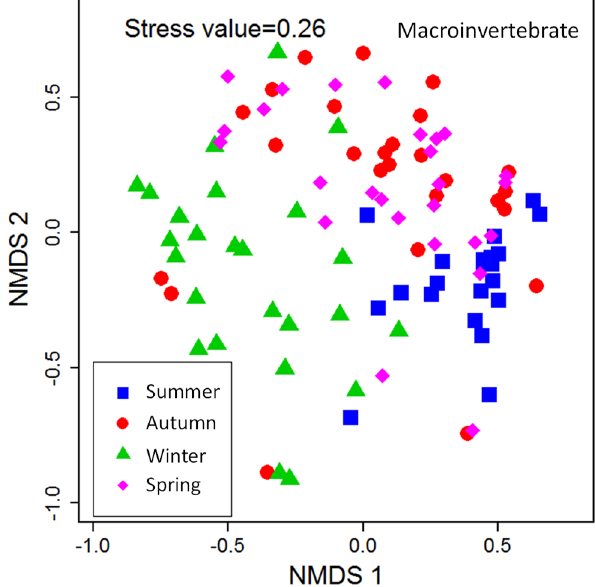
Figure 3. Nonparametric multidimensional scaling (NMDS) ordination of sampling sites based on the relative abundance data of benthic macroinvertebrates across different seasons.